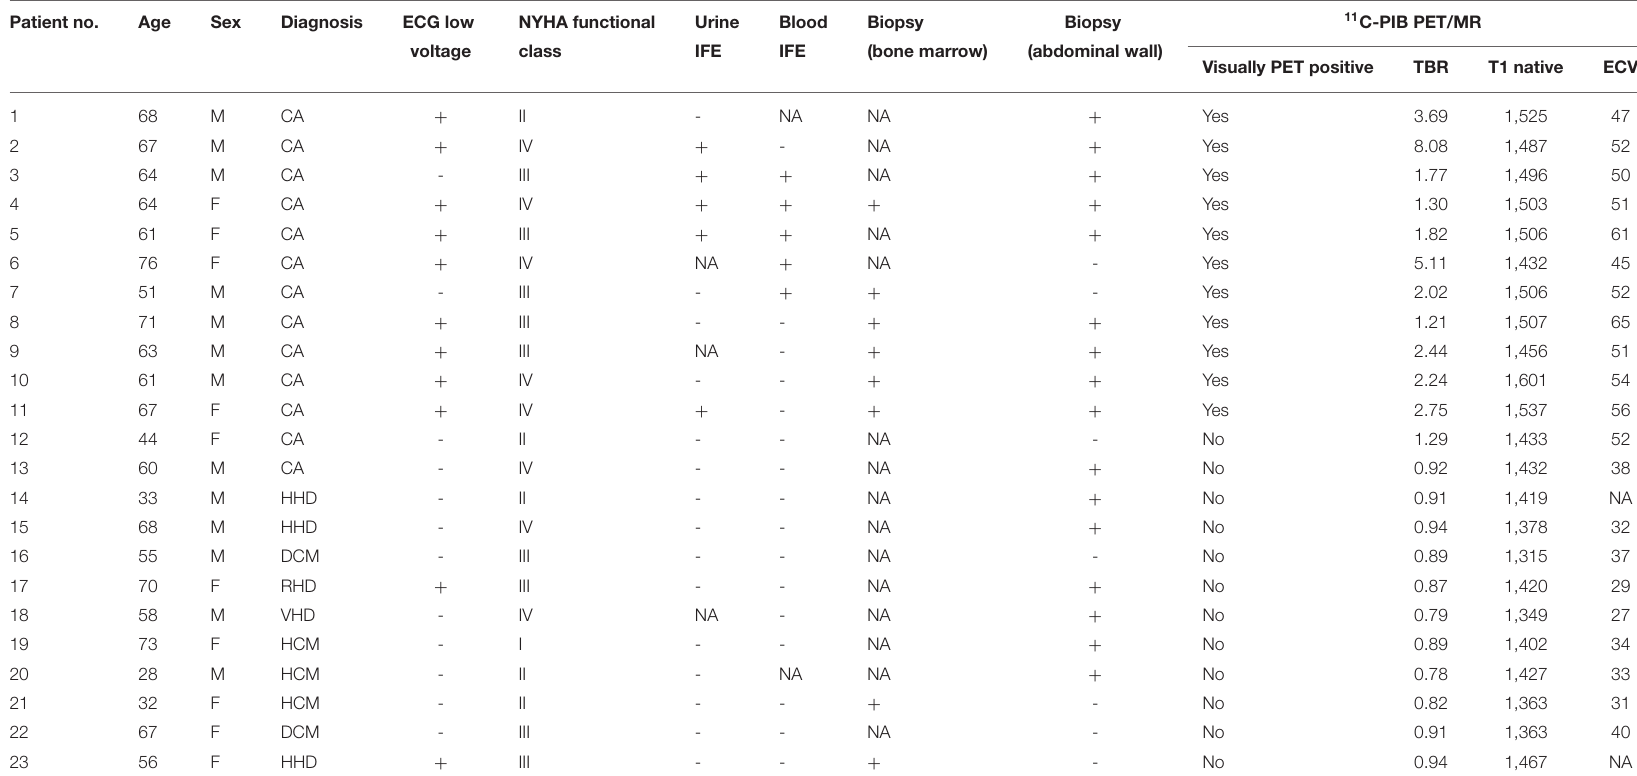
TABLE 1 | Comparison of the baseline clinical data and 11 C-PIB PET/MR parameters between patients with and without cardiac amyloidosis (CA). Patient